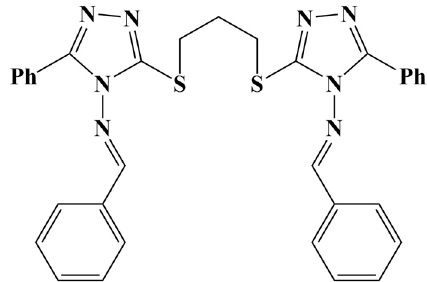
Figure 35. The ligand of the complex presented in